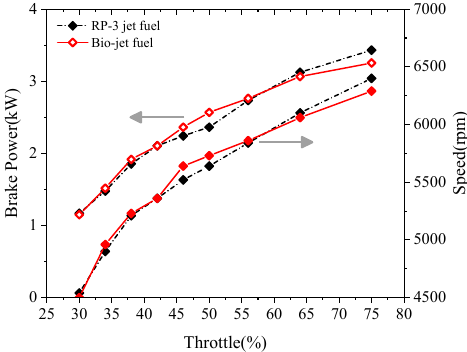
Figure 6. Variation of brake power and speed against throttle opening.